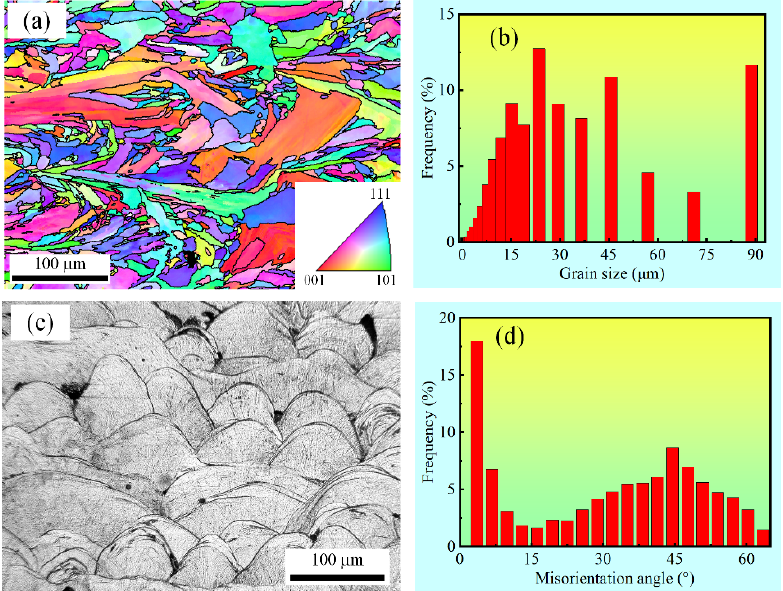
Figure 7. The residual stress distribution in the depth direction of the untreated, SP and SGP samples.